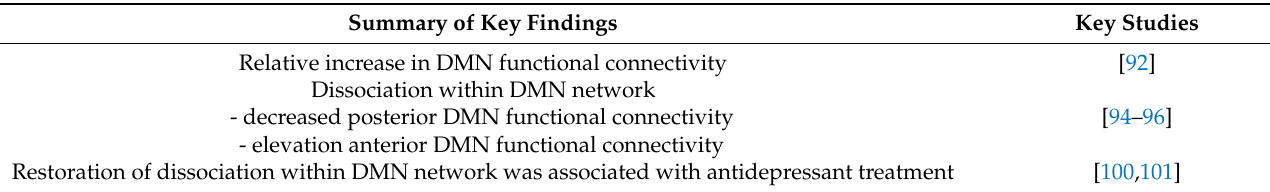
Table 1. Summary of key findings of resting-state functional MRI (rs-fMRI) studies associated with the default mode network (DMN) in late-life depression (LLD) patients included in the review. Summary of Key